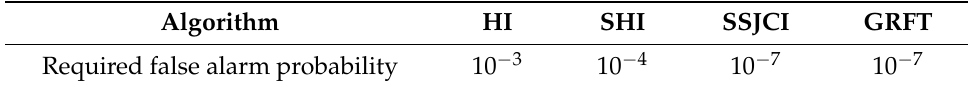
Table 5. Real data processing by the four